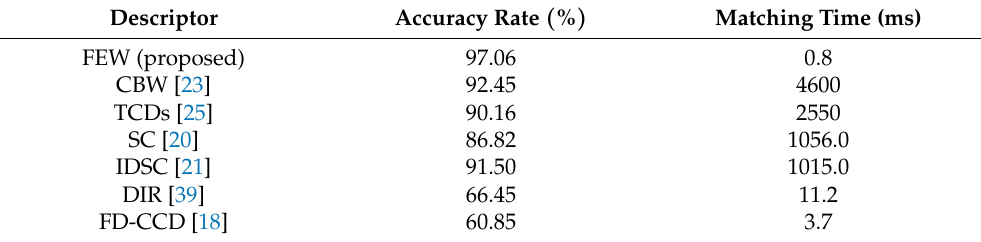
Table 4. Accuracy rate and matching time of our descriptor and some other descriptors on the Swedish plant